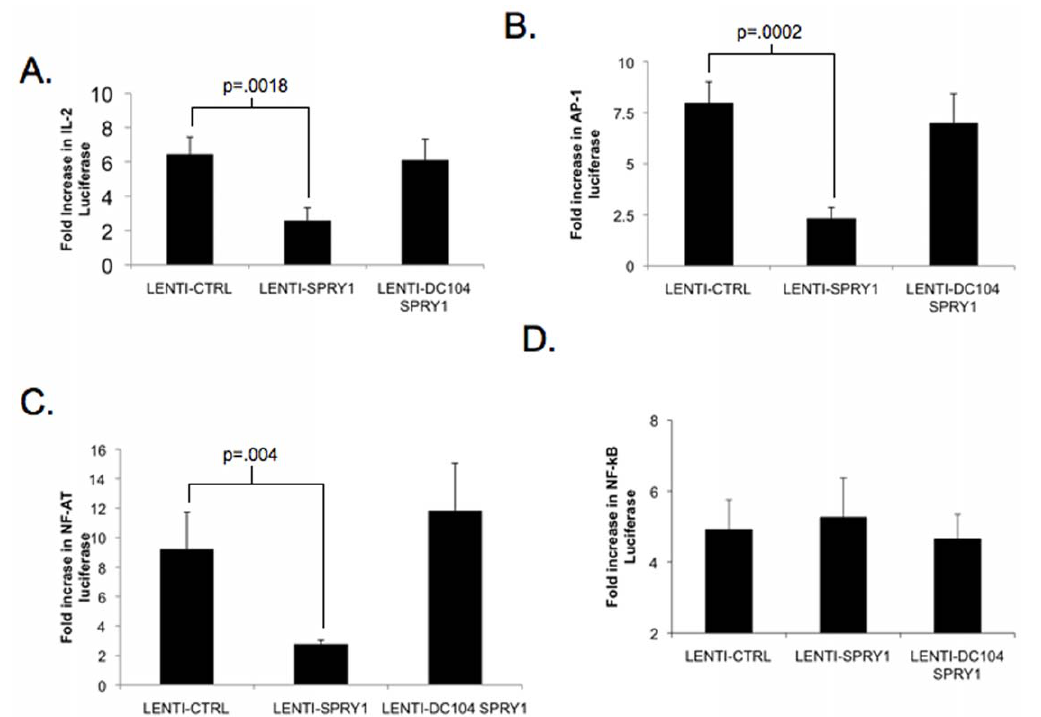
Figure 6. Spry1 overexpression suppresses IL-2, AP-1, and NF-AT signaling. Jurkat T cells were transfected with either control vector (Lenti- CTRL), Sprouty-1 overexpression vector (Lenti-Spry1) or a mutant Spry1 overexpression vector that lacks the c terminal domain (Lenti-DC104 Spry1). Jurkats were also tranfected with either an IL-2 driving luciferase construct ( A ), an AP-1 driving luciferase construct ( B ), an NF-AT driving luciferase construct( C ), or an NF- k B driving luciferase construct ( D ). Jurkats were stimulated with anti-CD3 and luciferase activity was measured. Data are presented as fold increase in luciferase over unstimulated. Error bars represent one standard deviation of the mean. P values indicate statistical significance by student t-test. All experiments were performed at least three